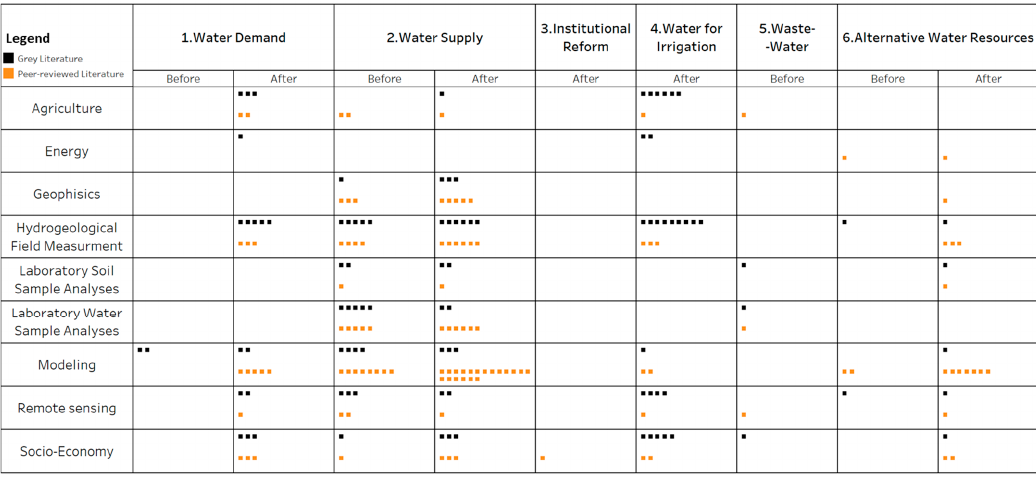
Figure 9. Relationship between the research focus areas (RFAs) and the MWI strategy